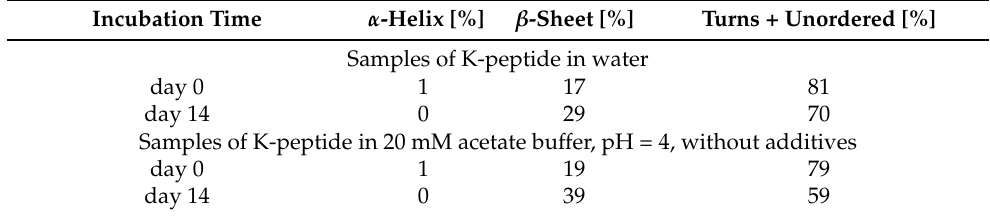
Table 2. The calculated components of the secondary structure for the samples of K-peptide in freshly prepared solutions and for samples incubated at 37 ◦ C for 14 days. Calculation method: CDSSTR algorithm with the reference data set 7